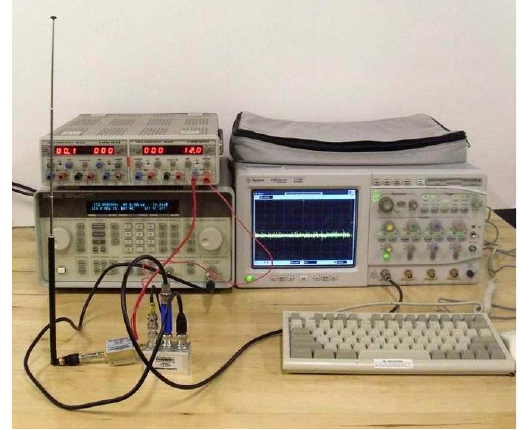
Figure 11. Photo of the WSD prototype.